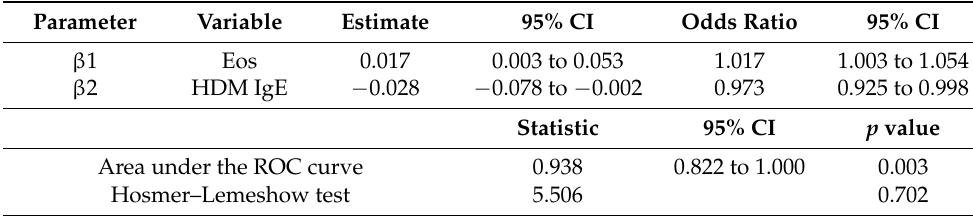
Table 4. Logistic regression model to predict a favorable lung function